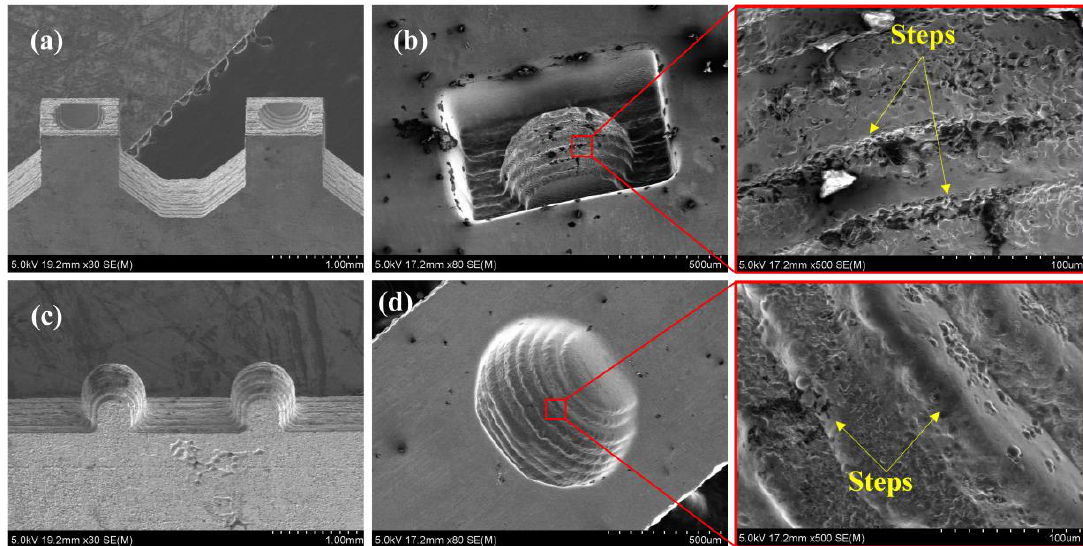
Figure 10. ( a , c ) Laminated 3D microelectrodes with steps; ( b , d ) Microstructures machined by